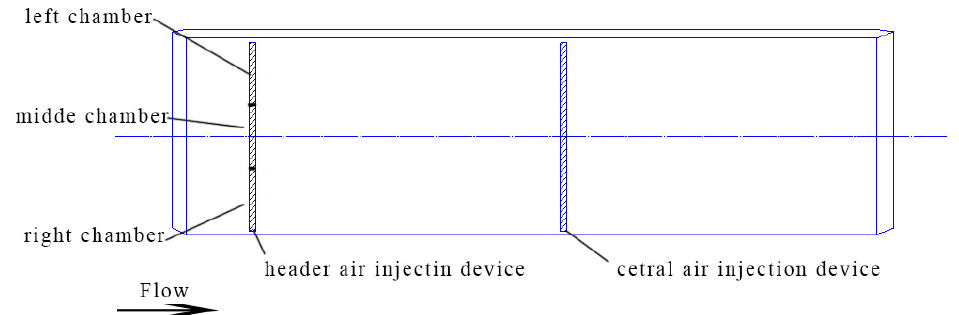
Figure 8. Chamber type of the jet hole.